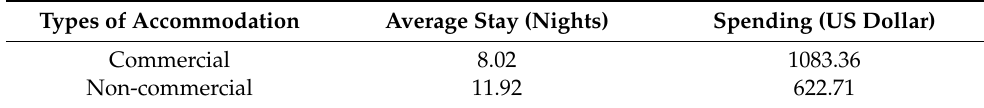
Table 1. Average overnight stays and spending of international tourists in 2019.